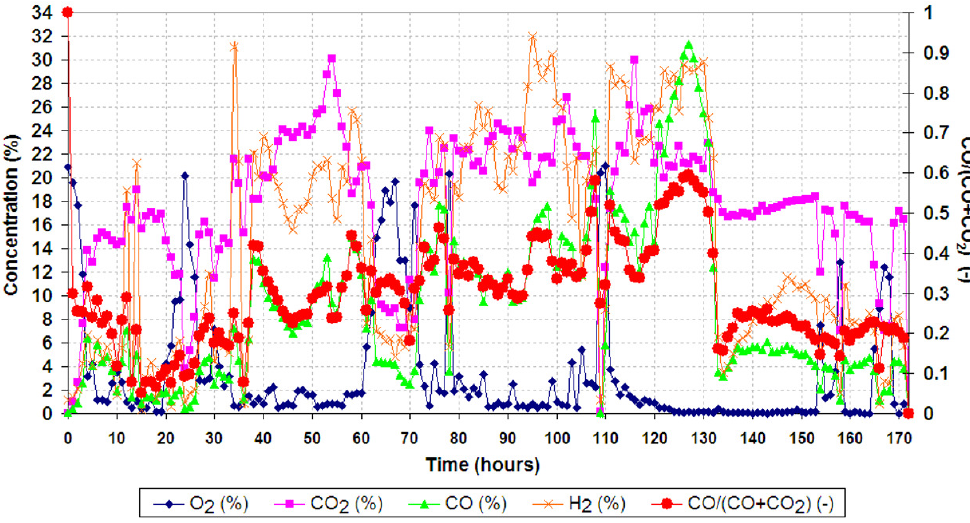
Figure 11. Measured concentrations and calculated ratio of CO/(CO + CO 2 ) [68].